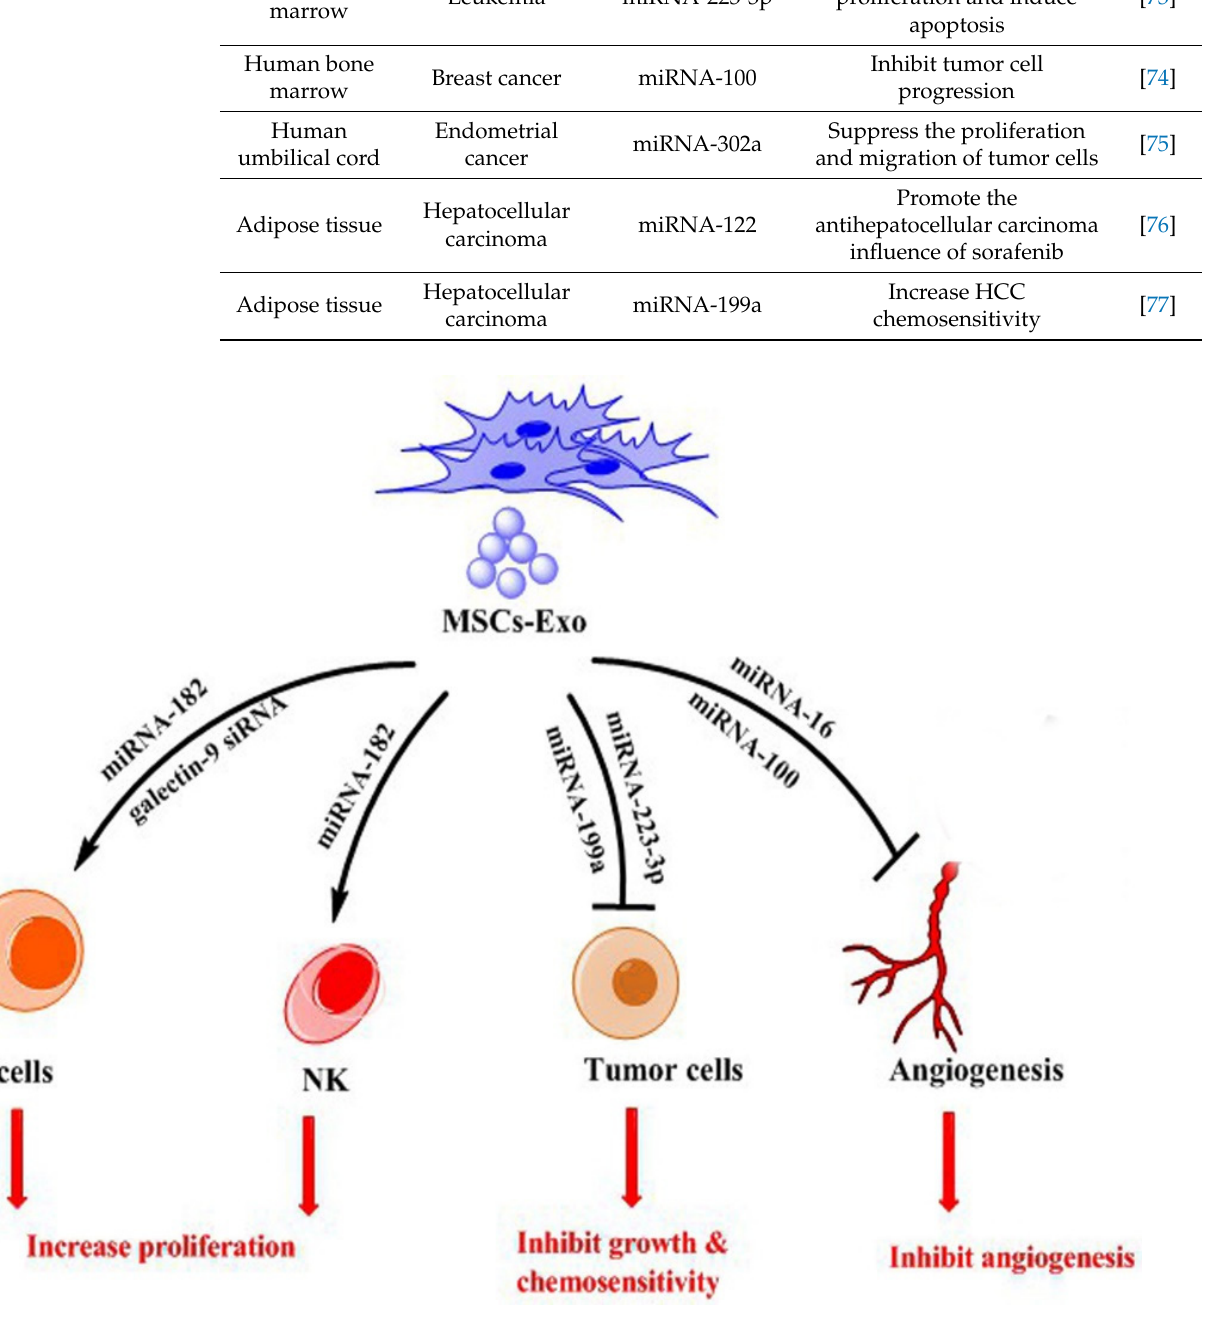
Figure 3. Role of exosomes from MSCs (MSCs-Exo) in inhibiting tumor.